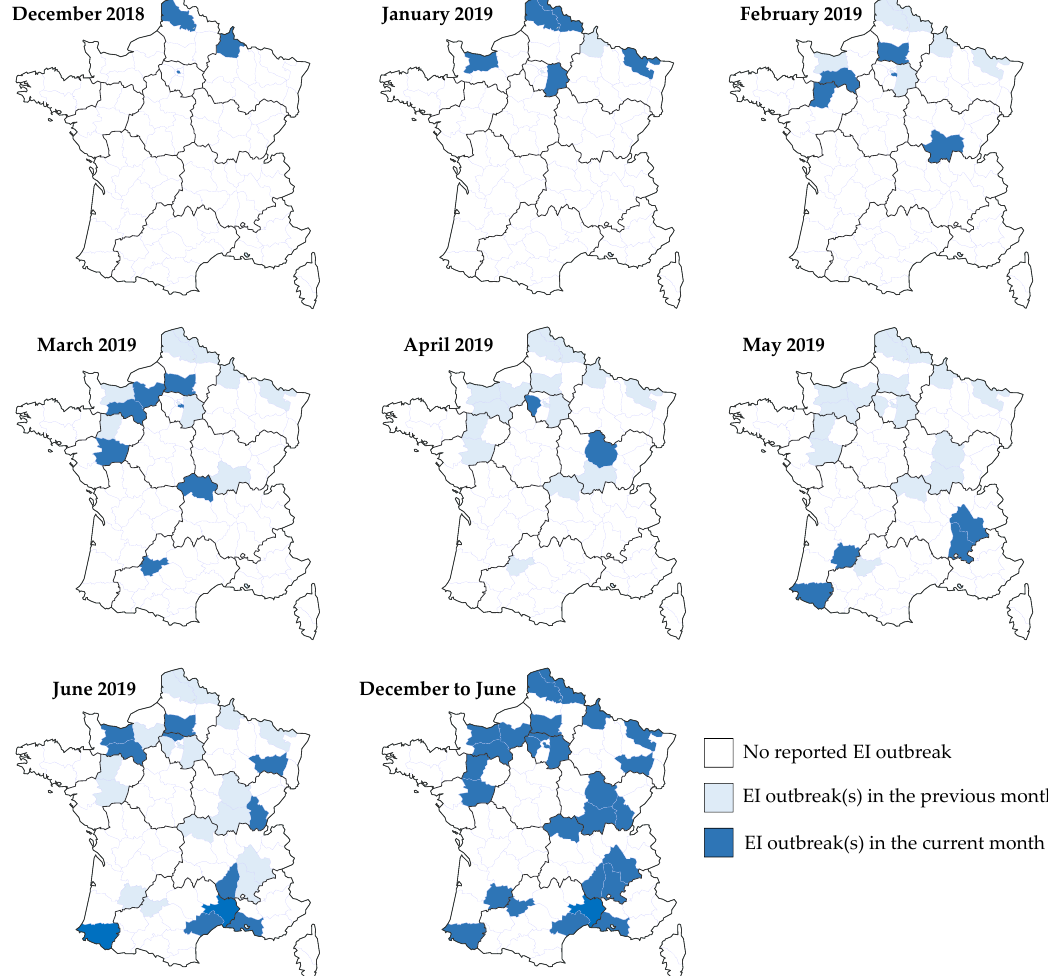
Figure 5. Localization of the French EI outbreaks at the county level, month by month. For each month, new EI cases are highlighted in dark blue, cases from previous months localized in the same county are highlighted in light blue.